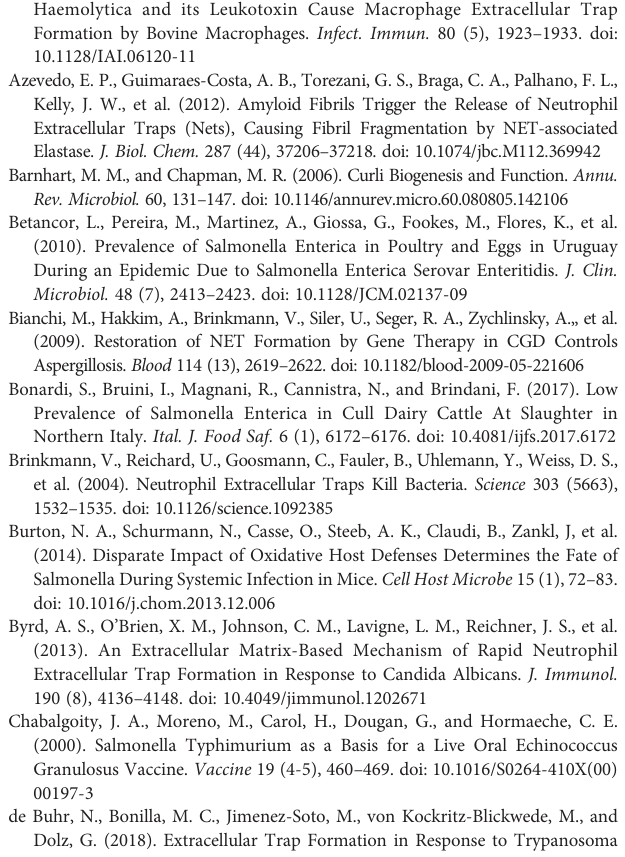
video rendered at 25 frames/sec). In red: membrane, blue: DNA, green: Salmonella . The scale bar represents 5 µm. Movie 2 | (Still image 2) . Tracking analysis of Salmonella . Each bacteria was tracked and represented by a colored dot, with its corresponding trajectory traced by a line of the same color. Bacteria that were trapped within the MET had a constrained movement inside the MET area. Movie SM1 | (Still image movie S1) . Salmonella within a MET with a different look-up table (LUT). Movie 1 was processed so the emission color of channel was changed to a red/green LUT. High fl uorescence intensity values are observed in green and low intensity valuesin red. The sameLUT was applied for both green and blue channels (for GFP and DNA,